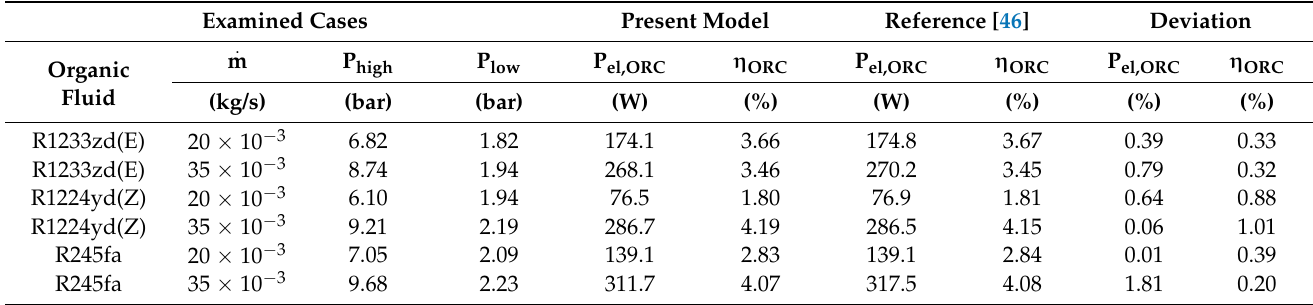
Table 5. Validation of the ORC with experimental data from the literature.